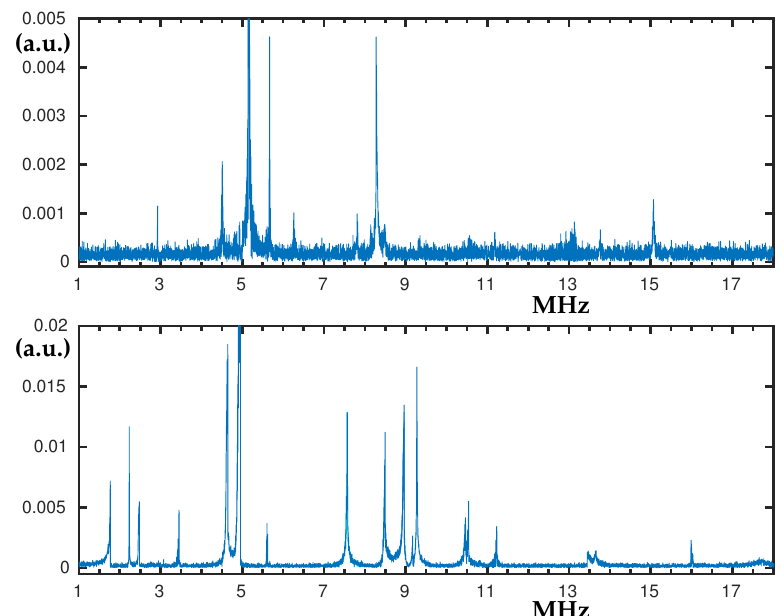
Figure A9. Broadband frequency response spectra of the two additional fractal resonators.